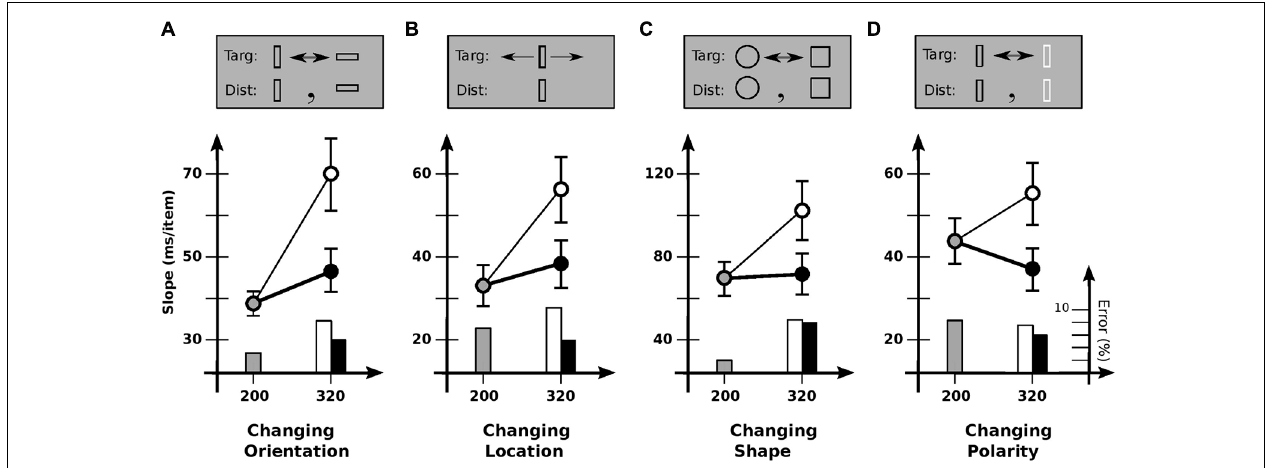
(C) Changing shape. Slope for base cadence (69.4 ms/item) is strongly affected by an increase in off-time (101.9 ms/item) but not an increase in on-time (70.2 ms/item). (D) Changing polarity. Slope for the base cadence (43.2 ms/item) is significantly affected by an increase in off-time (55.7 ms/item), but marginally affected by an increase in on-time (37.6 ms/item). Error bars indicate standard error of the